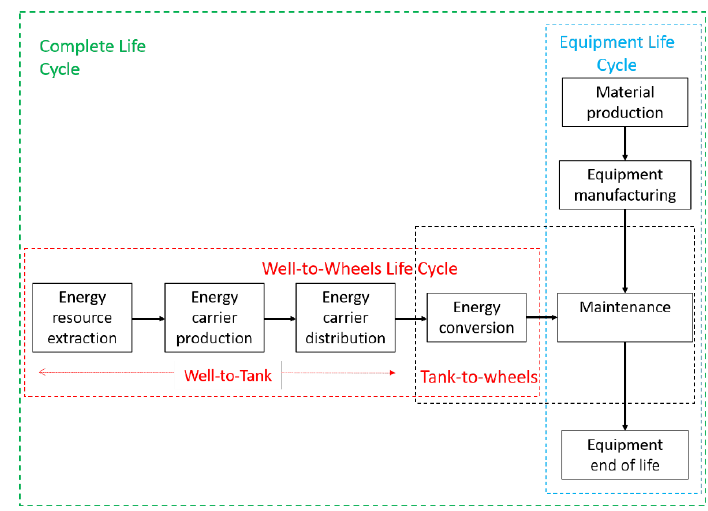
Figure 1. Simplified view of the well-to-wheels (WtW) and equipment flows [2]. (Reproduced with permission from [2], Springer, 2014).